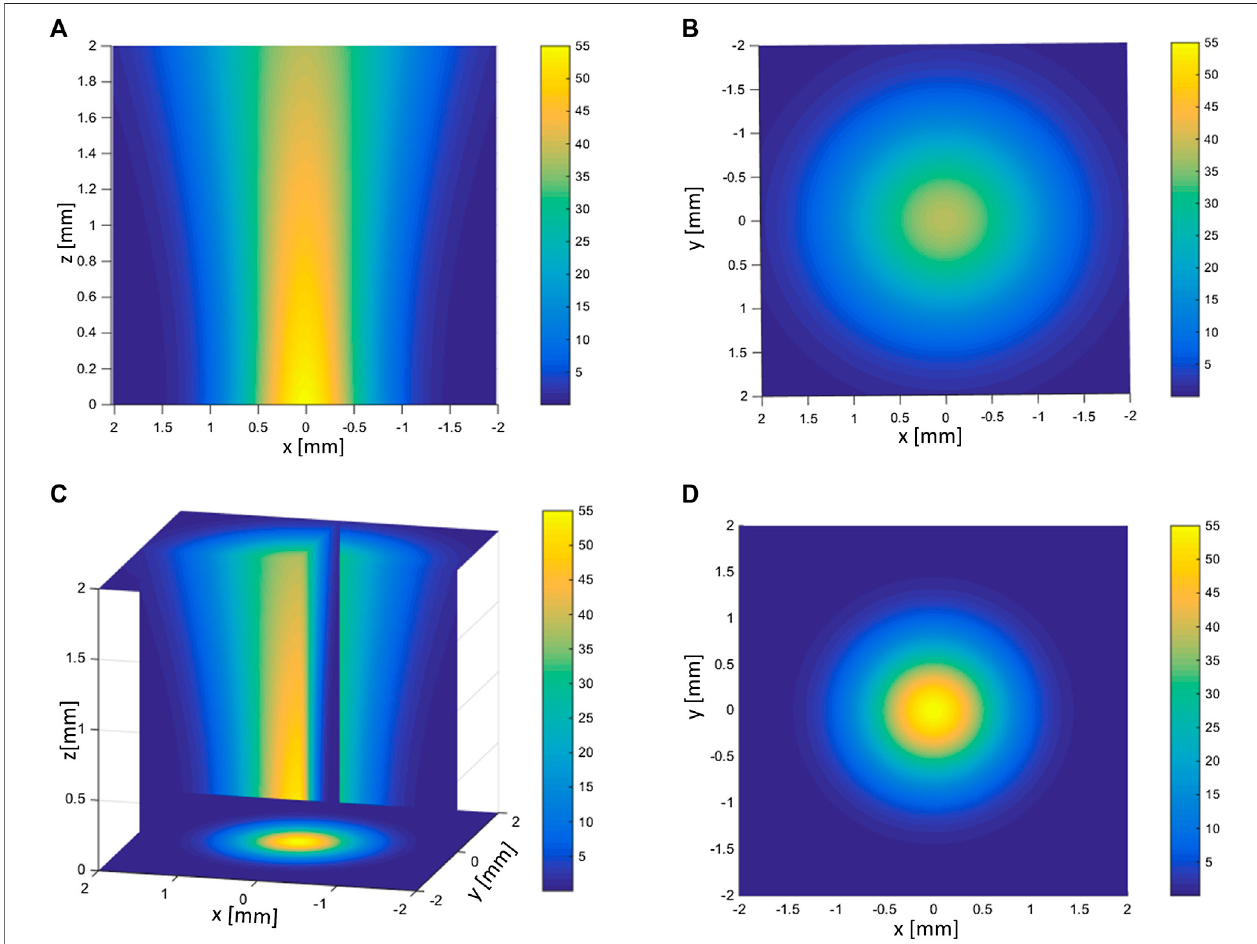
FIGURE4| Illustrationofbeamintensitydecayandbroadeningduetoscatteringfromsemi-transparentpolypropylenelayer (A) cross-sectionalviewofinputbeam pro fi le (B) cross-sectional view of transmitted beam including scattering effect, (C) 3D view and (D) 2D view on xz-plane.